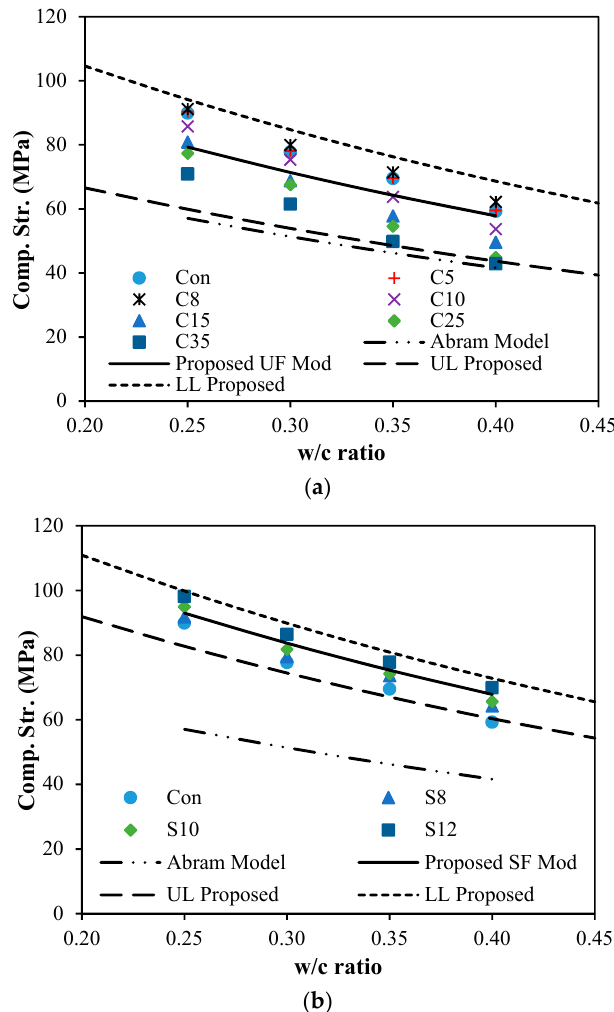
Figure 11. Strength vs. w/c ratio for different ultrafine dosages at 28 days: ( a ) strength vs. w/c ratio for different UF dosages at 28 days; ( b ) strength vs. w/c ratio for different SF dosages at 28 days.